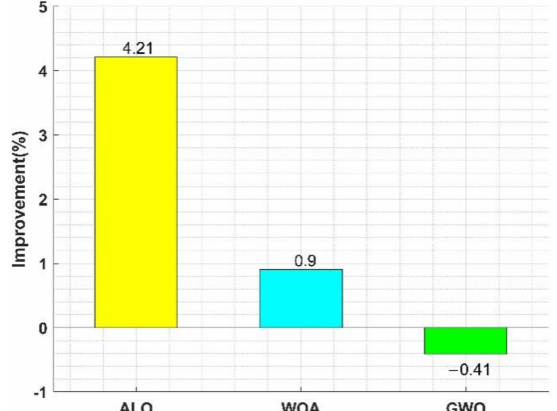
Figure 11. Efficiency improvement of ALO, GWO, and WOA with respect to unscheduled